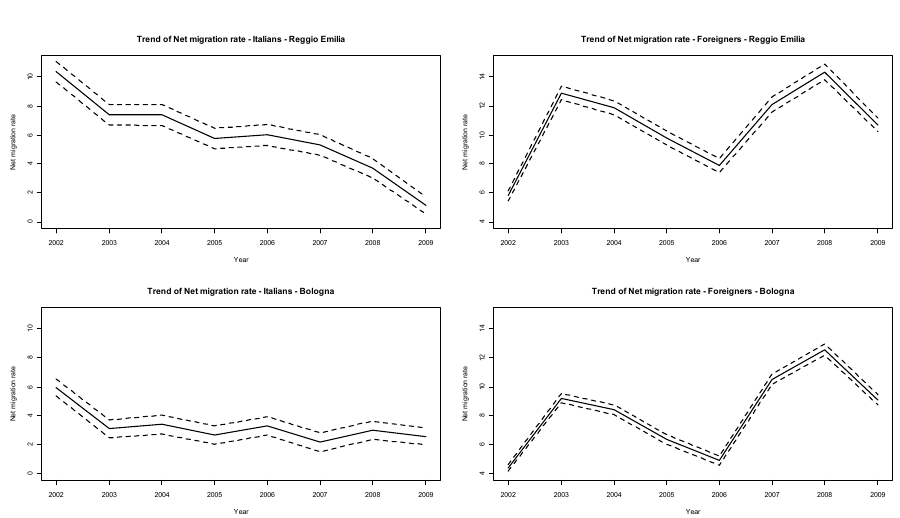
Figure 1 – Temporal trend of the net migration rate and 95% confidence bands for Italians and for- eigners in the provinces of Reggio Emilia and